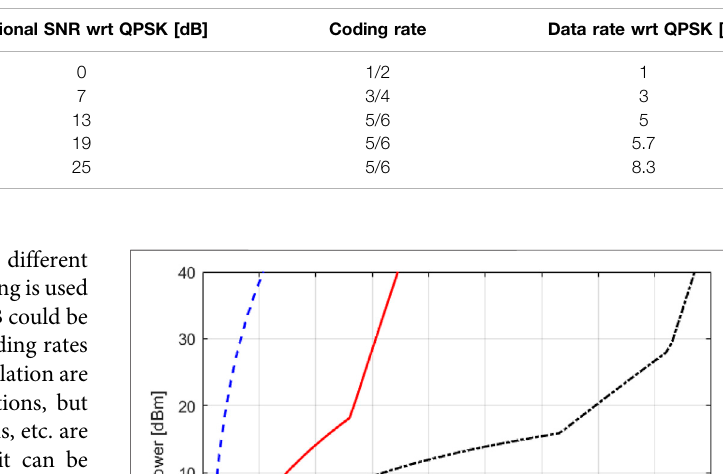
TABLE 2| Required SNRper symbolfor different modulations (without coding) when the target BER is10 – 5 , representativecoding rates foreach modulation and datarates relative to QPSK.